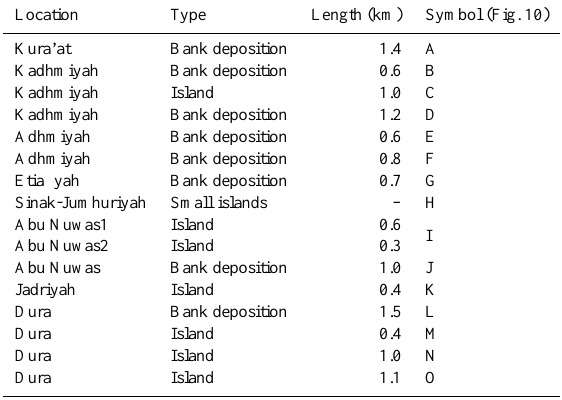
Table 2. Main observed obstacles in Tigris River within Baghdad City in 2008.